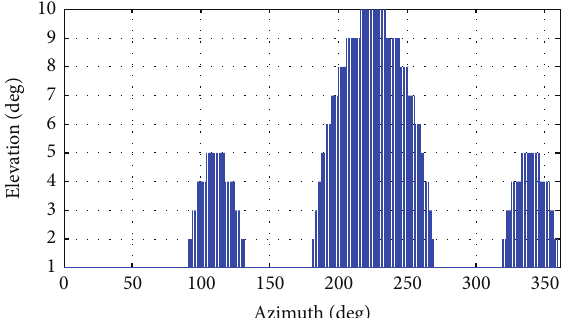
Figure 21: The distribution of azimuth and elevation angles for which the TOA equation cannot be